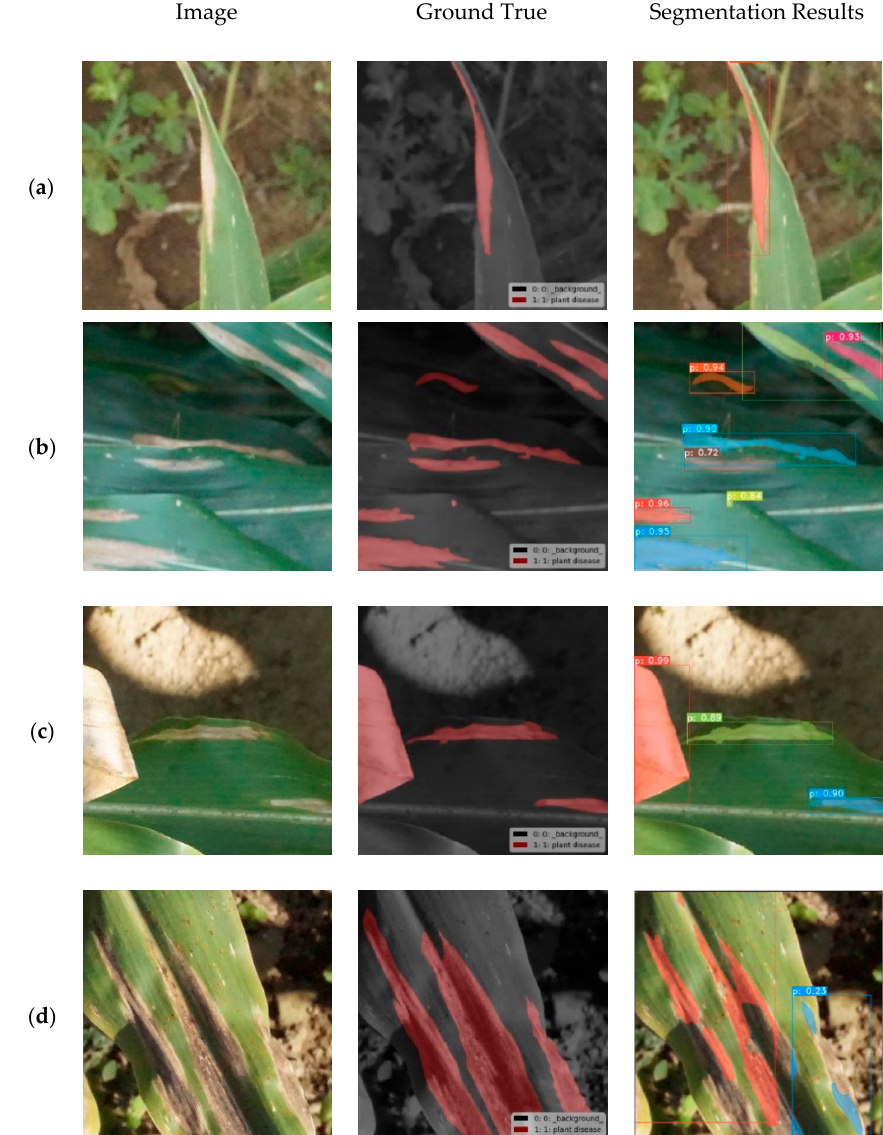
Figure 10. Example diagrams of segmentation results of maize leaf lesions. ( a ) weeds; ( b ) mutual